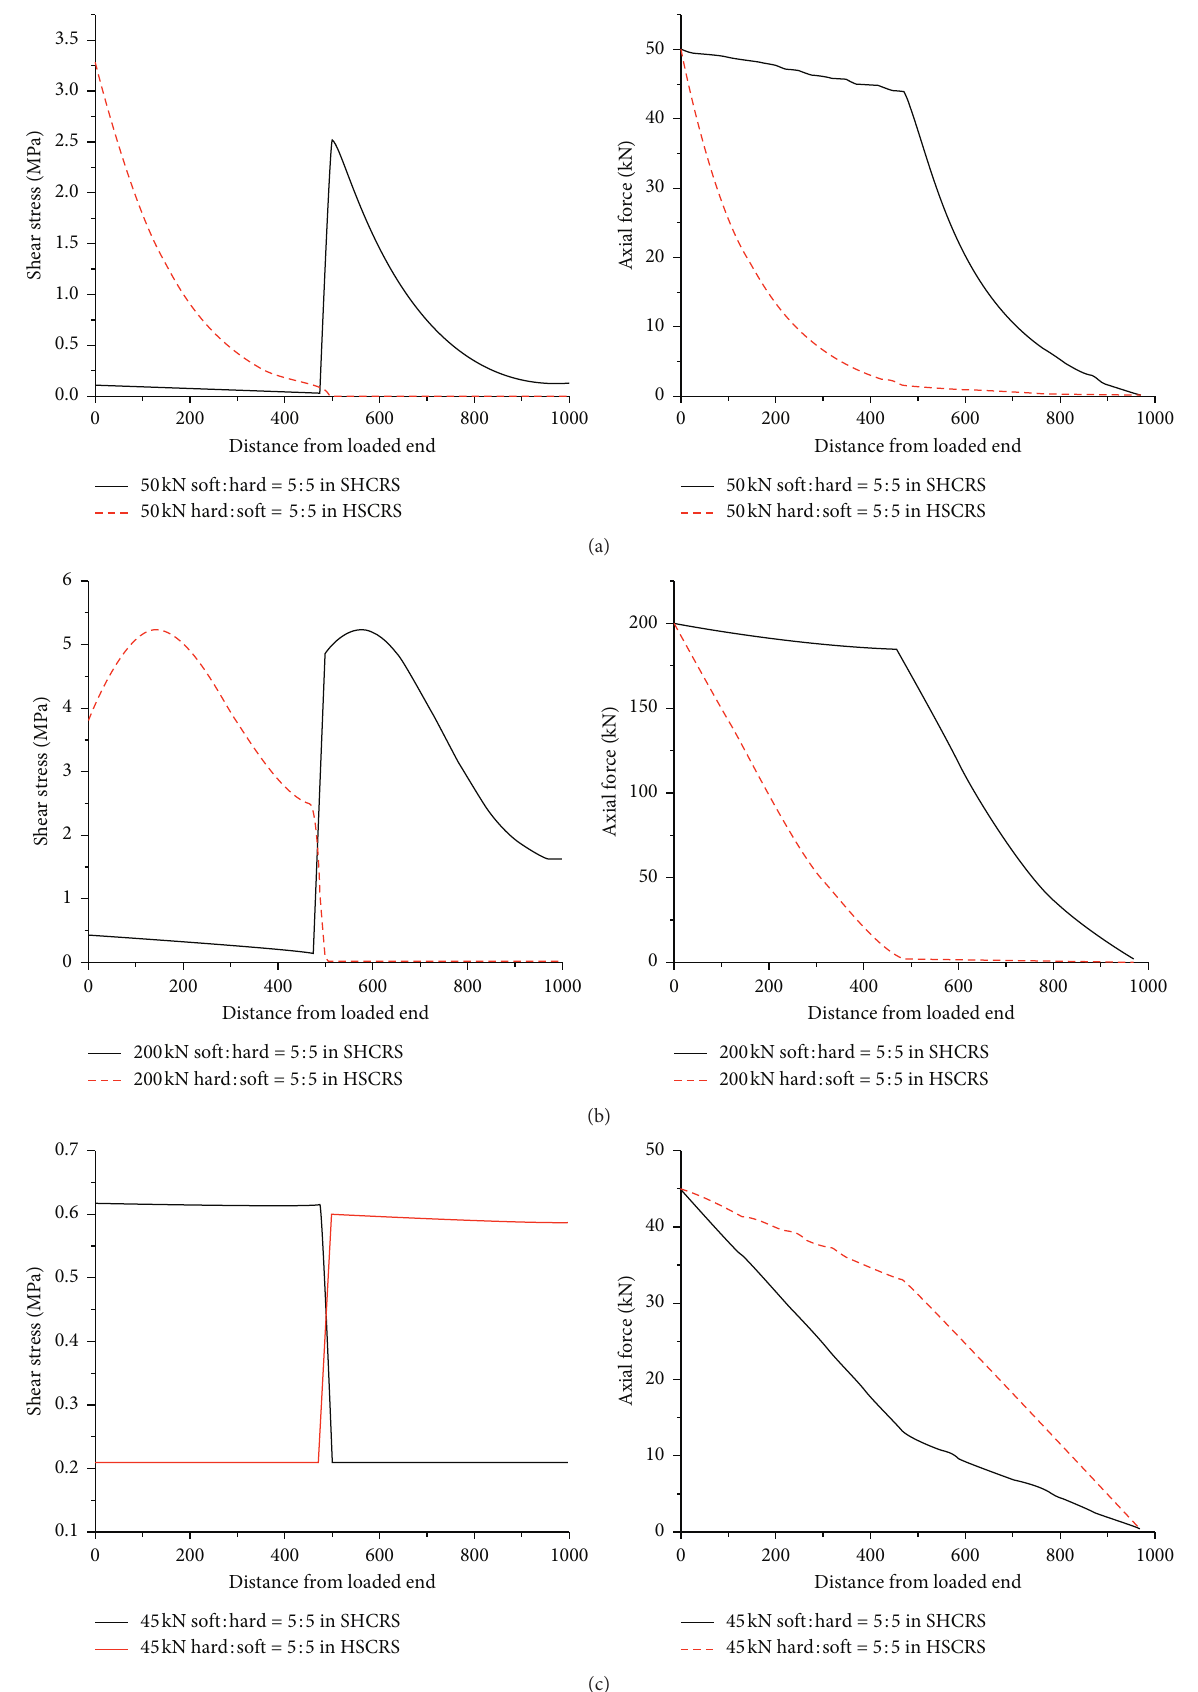
Figure 13: Shear stress (left) and axial force (right) distributions curves in SHCRS and HSCRS. (a) Linear stage. (b) Nonlinear stage. (c) Softening and debonding